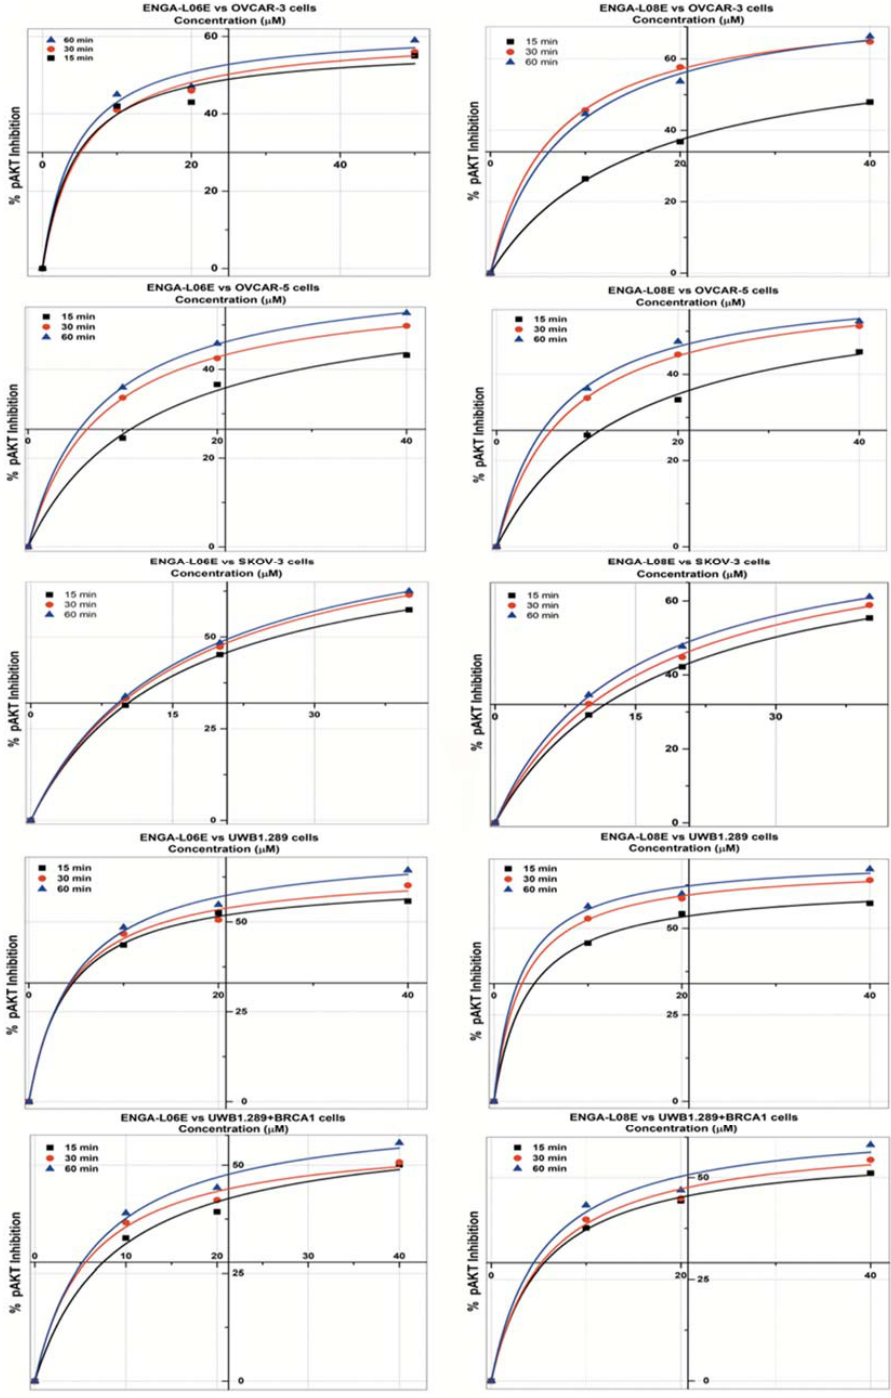
Figure 2. Michaelis Menten model (y = Vmax ∗ x/(Km + x) inhibition curves of AKT phosphorylation by ENGA-L06E and ENGA-L08E in SKOV-3, OVCAR-3, OVCAR-5, UWB1.289, UWB1.289 + BRCA1 human ovarian cancer cell lines, treated with 10, 20, and 50 µ M at di ff erent time conditions (15, 30, 60 min) ( p <